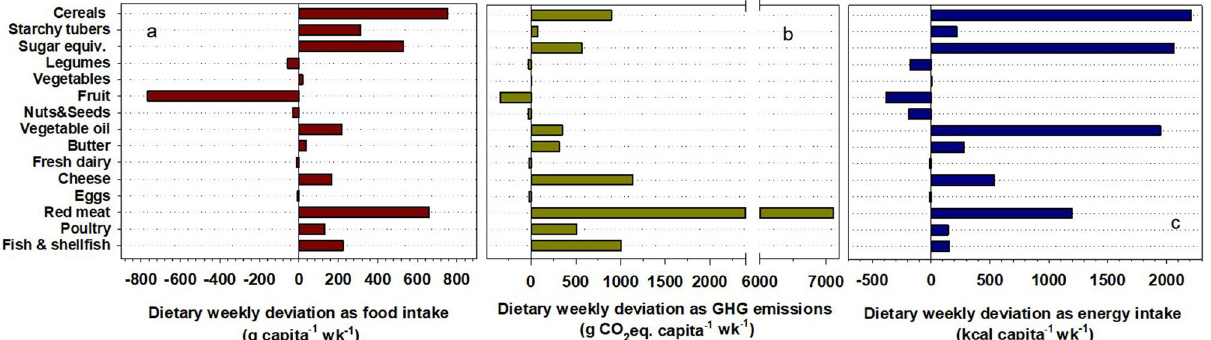
Figure 2. Deviations of food consumption patterns of Mediterranean citizens (7MED) from the reference MD. Data are represented as total weekly deviation of each analysed food group to take into account a complete dietary plan with specific weekly frequency consumption of different food items. Differences are reported as ( a ) fresh food weight intake (g), ( b ) E GHG derived from C footprint of consumed food items, ( c ) calorie intake. Positive values indicate an extra weekly intake, negative sign a deficit weekly